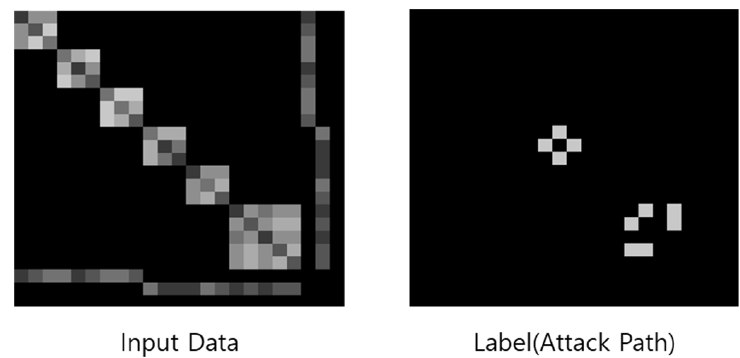
Figure 8. The examples of input data and labels used for attack